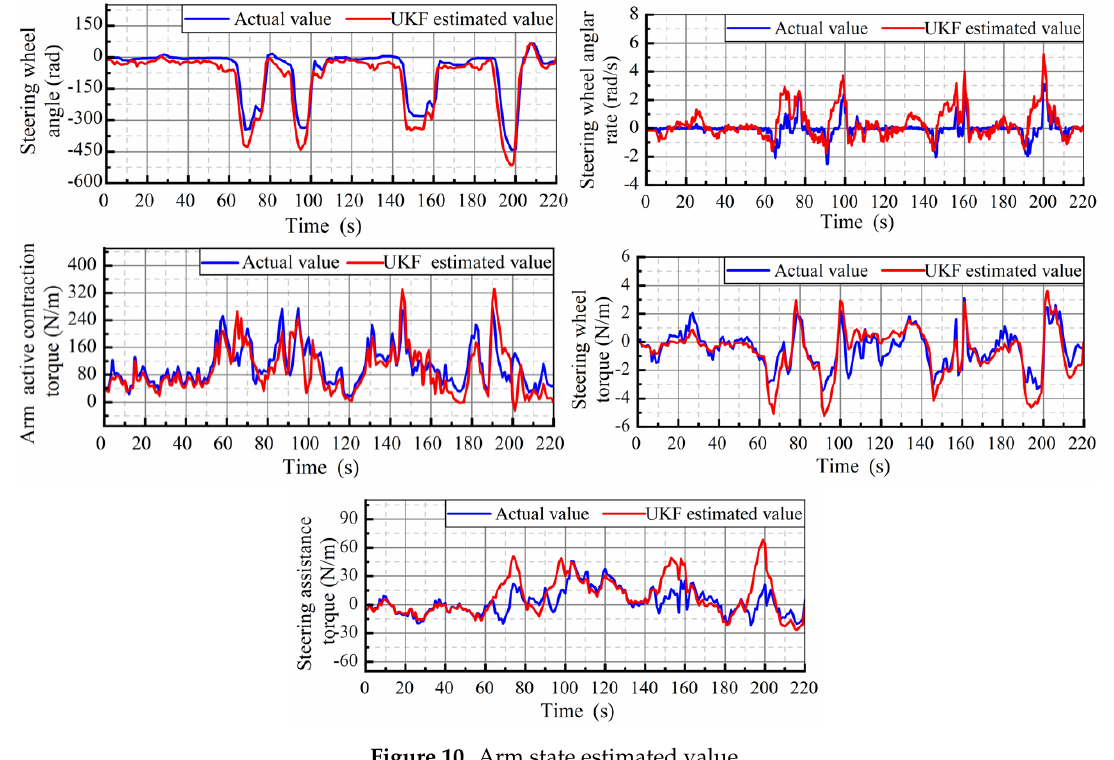
Figure 9. Vehicle state estimated value.